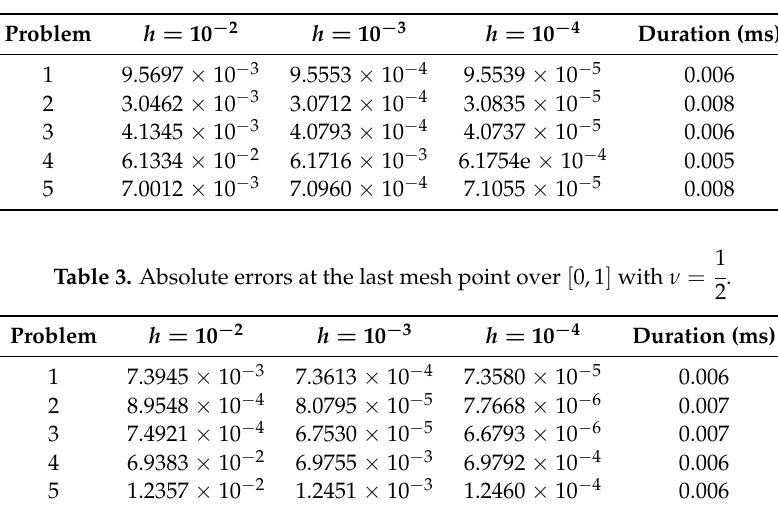
Table 2. Absolute errors at the last mesh point over [ 0,1 ] with ν =